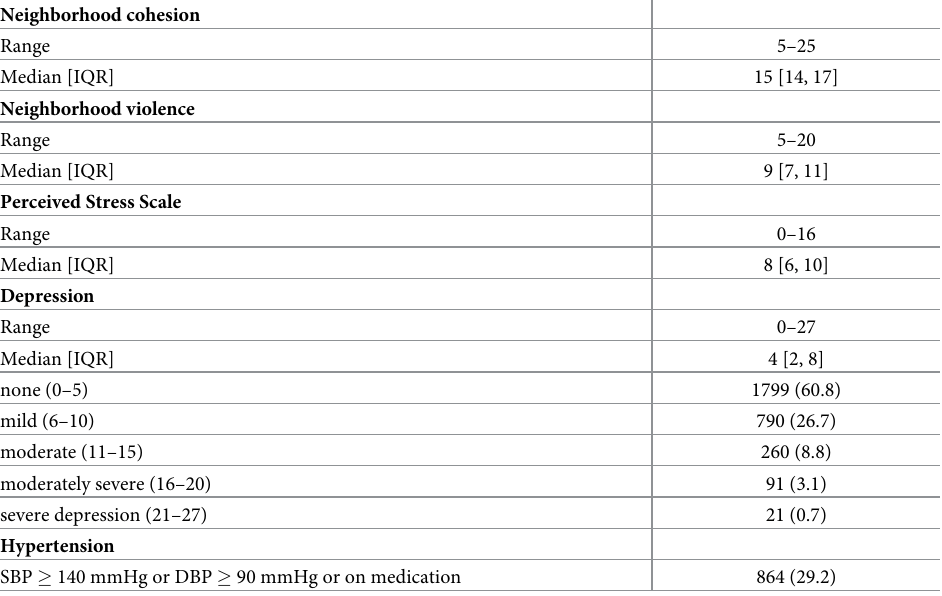
Table 2. Neighborhood factors, stress, depression and blood pressure in the Haiti CVD cohort